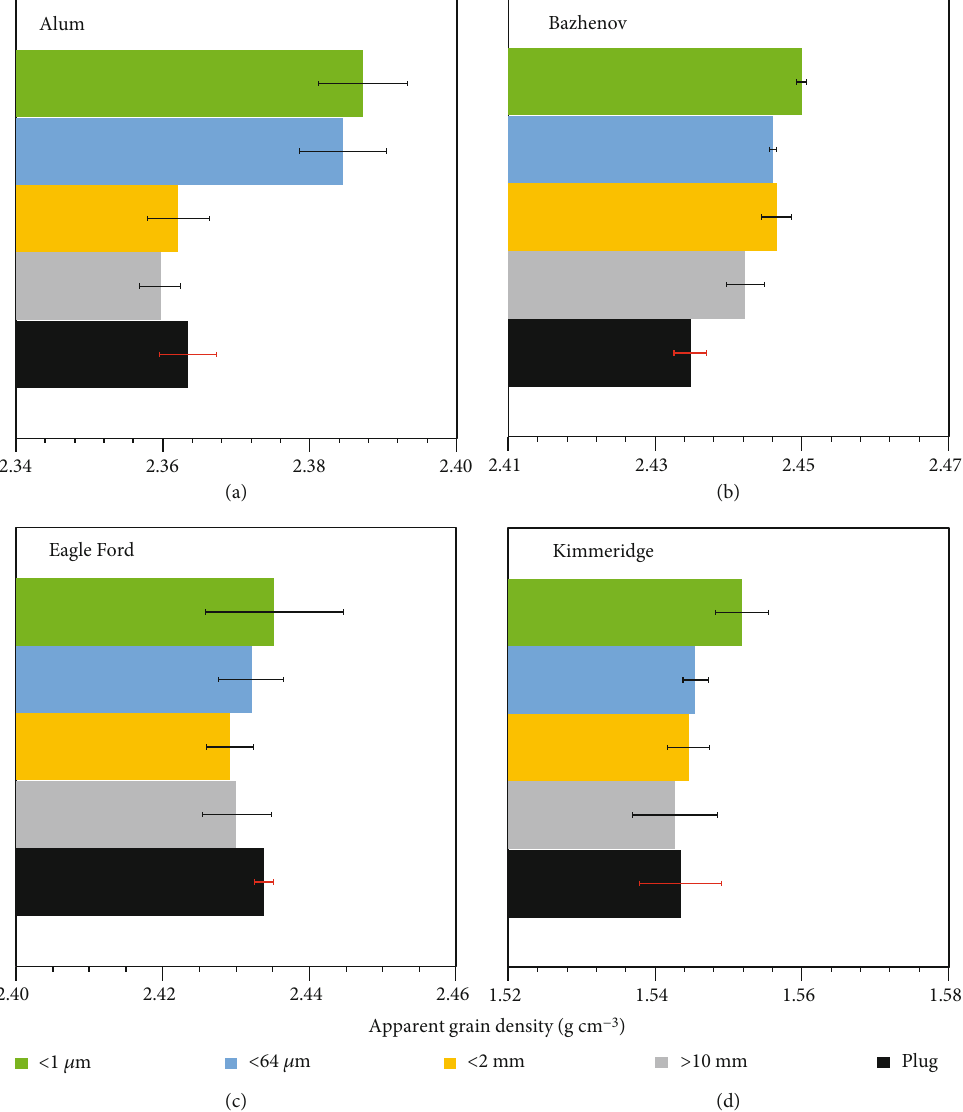
Figure 3: Apparent grain density of plugs and di ff erent particle sizes for shales from (a) Alum, (b) Bazhenov, (c) Eagle Ford, and (d) Kimmeridge